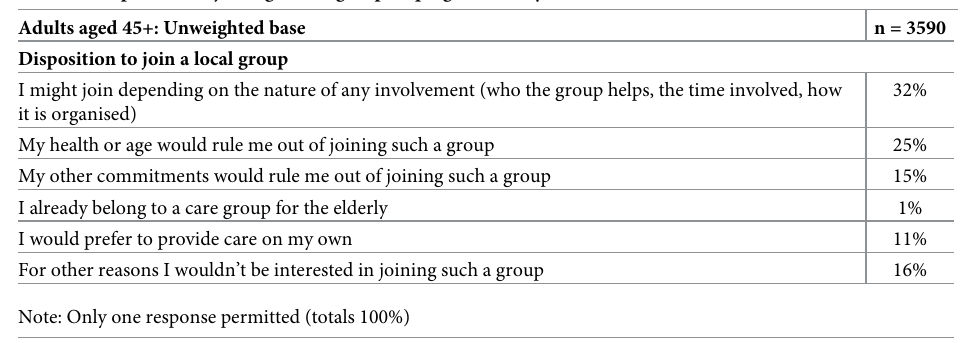
Table 5. Disposition to joining a local group helping the elderly.